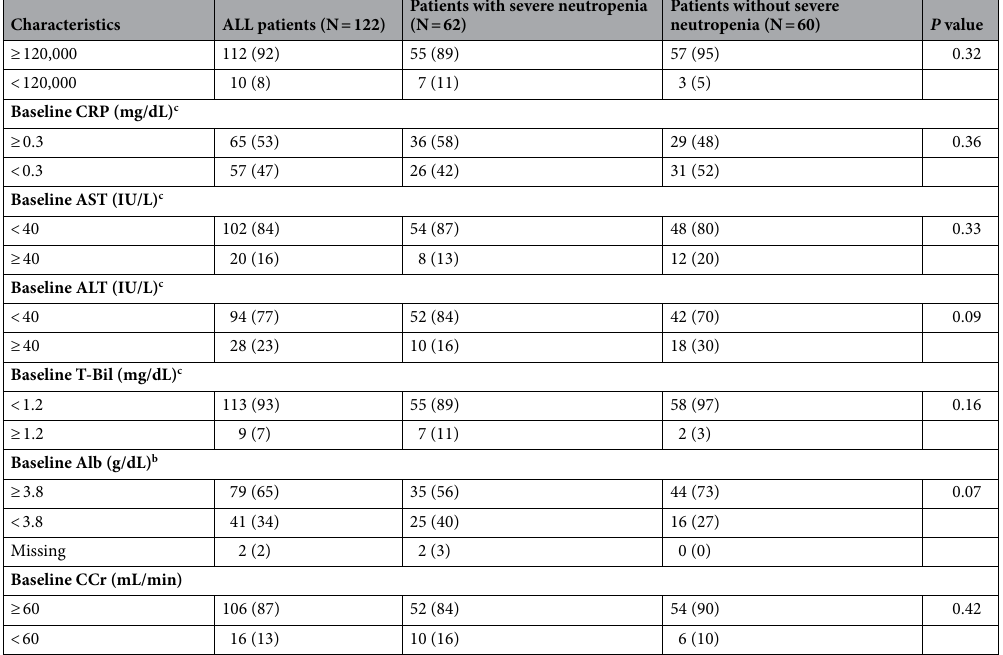
Table 1. Baseline patient characteristics. The data are reported as the number (%) or median (range). The p -value was calculated by comparing patients with and without severe neutropenia. ECOG-PS Eastern